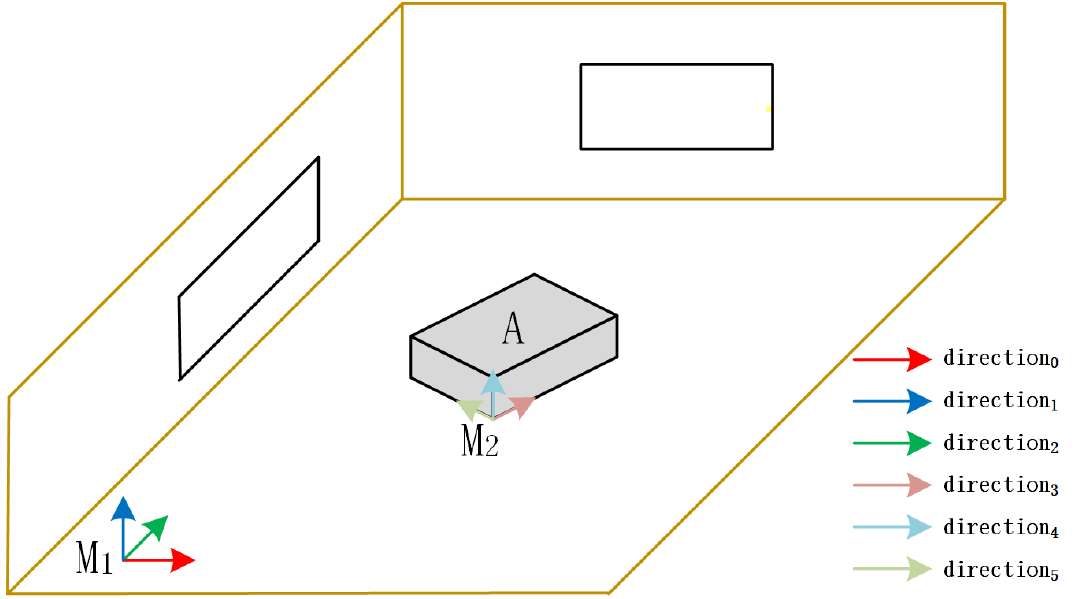
Figure 2. The dominant directions in the proposed method. The direction 0 to direction 5 constitute a set of unit vectors {𝑑 𝑖𝑤 } . The direction 0 to direction 2 constitute the 𝑀 1 .